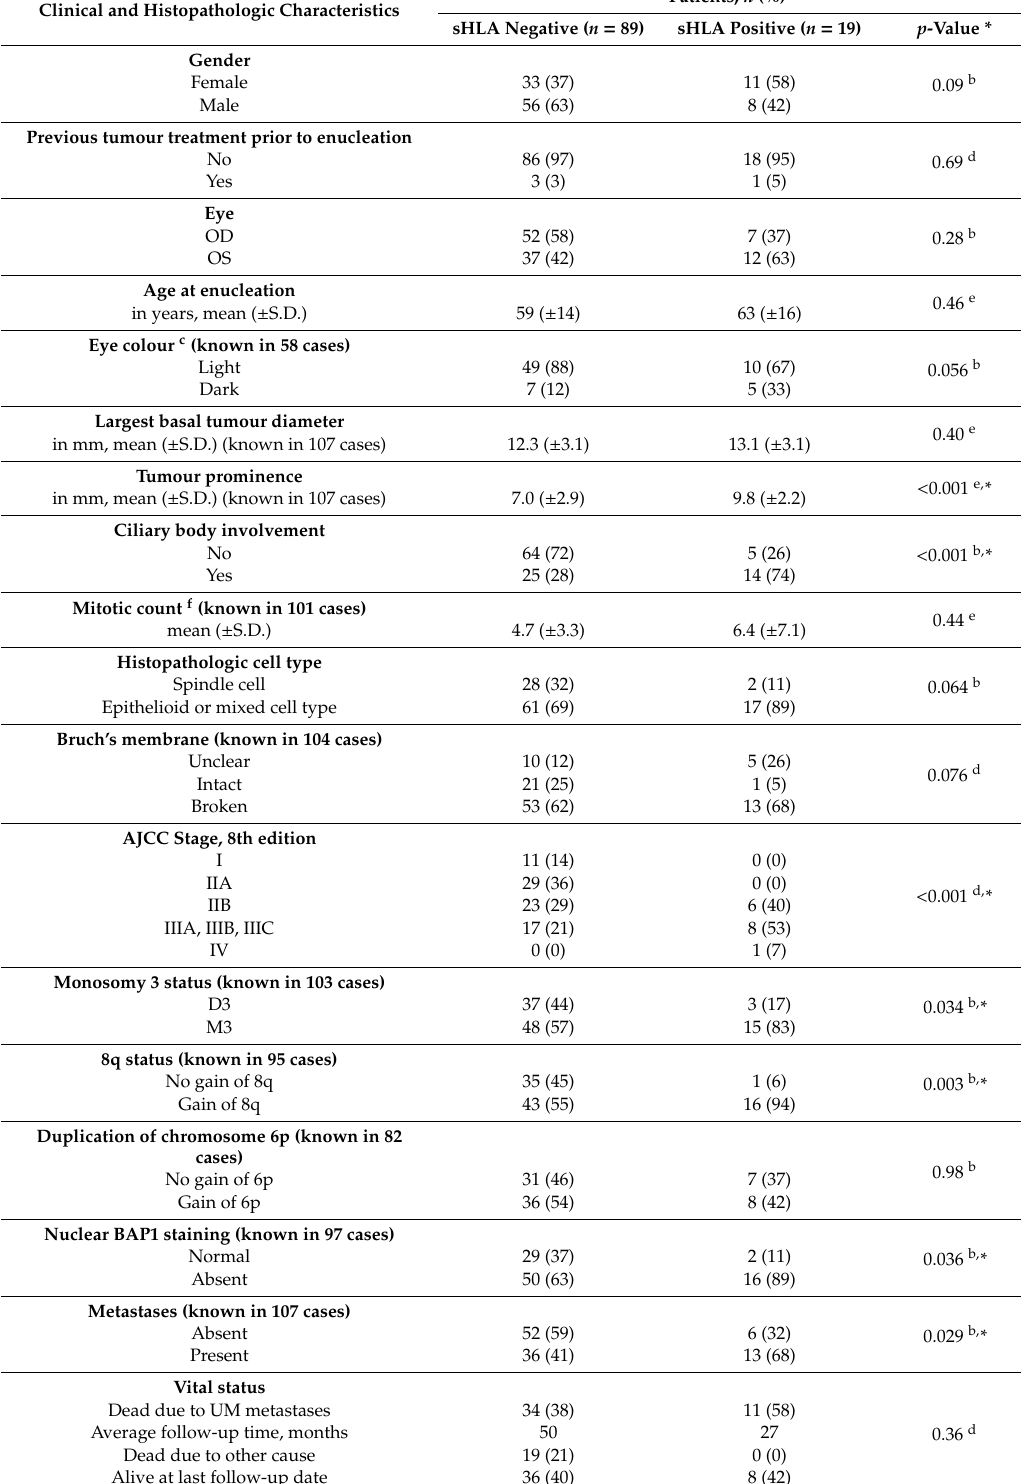
Table 1. Characteristics of patients with a uveal melanoma (UM) that underwent enucleation in the Leiden University Medical Center (LUMC) between 1999 and 2016 ( n = 108), categorised as soluble HLA (sHLA) negative or sHLA positive, based on the level of sHLA in the aqueous humour. Clinical and Histopathologic